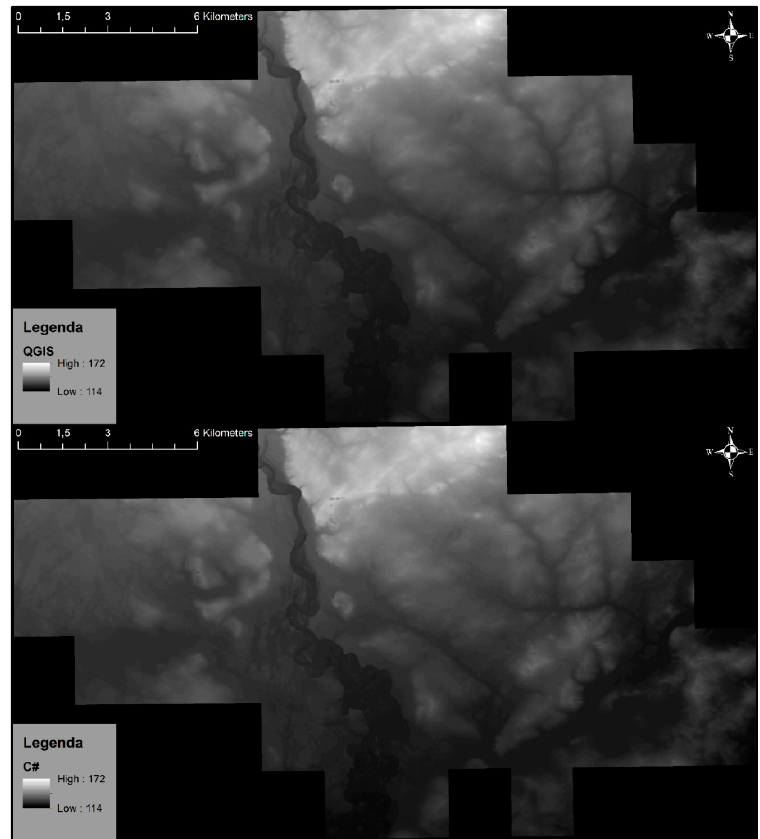
Figure 5. A comparison between a manually-connected Digital Terrain Model QGIS and one prepared using C#.